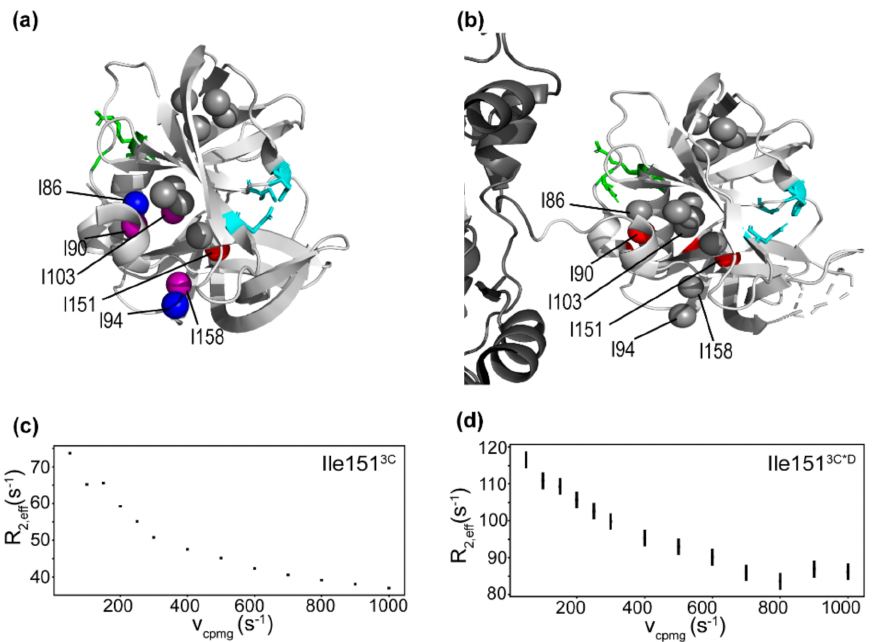
Figure 3. Conformational exchange processes in 3C and the 3C domain of 3CD on the µ s-ms timescale. ( a ) R ex , the contribution to relaxation from conformational exchange, from multiple quantum 1 H- 13 C CPMG (Carr-Purcell-Meiboom-Gill) relaxation dispersion for 3C is plotted as colored spheres (gray: no detectable exchange, blue < 2–4 s − 1 , purple: 4–10 s − 1 , red > 10 s − 1 ). The protease active site is shown in cyan and the RNA binding site is shown in green. ( b ) Multiple quantum 1 H- 13 CHHHH CPMG relaxation dispersion curve for Ile151 in 3C. The effective relaxation rate R 2eff is plotted against the CPMG pulsing frequency. ( c ) R ex from multiple quantum 1 H- 13 C CPMG relaxation dispersion for 3CD is plotted as colored spheres (gray: no detectable exchange, red > 10 s − 1 ). ( d ) Multiple quantum 1 H- 13 CHHHH CPMG relaxation dispersion curve for Ile151 in the 3C domain of